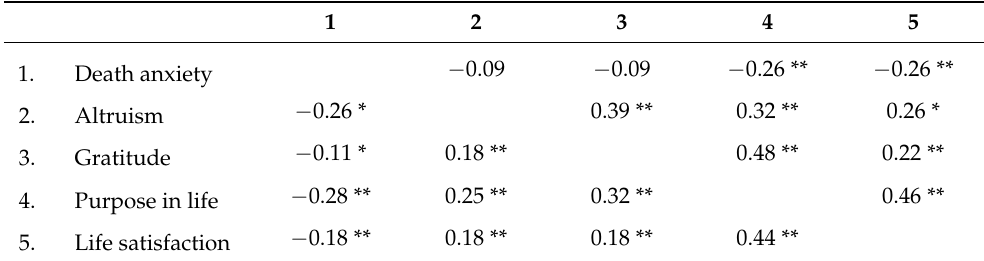
Table 2. Zero-order correlations among study